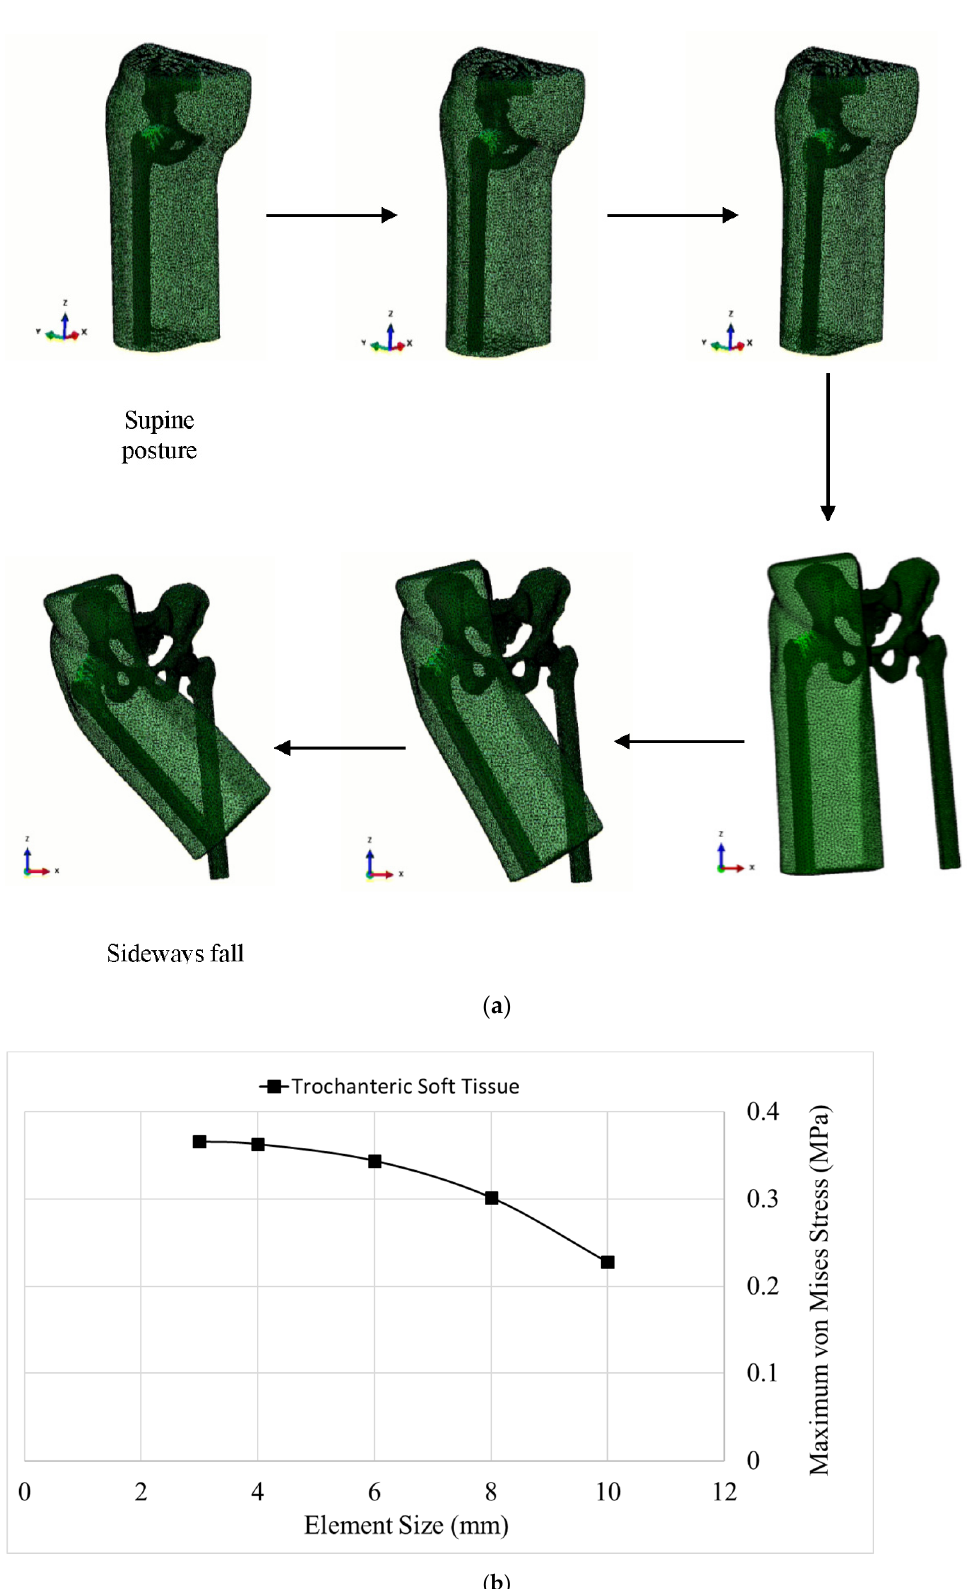
Figure A2. ( a ) Internal rotation and adduction from supine to sideways fall posture; ( b ) mesh convergence check.